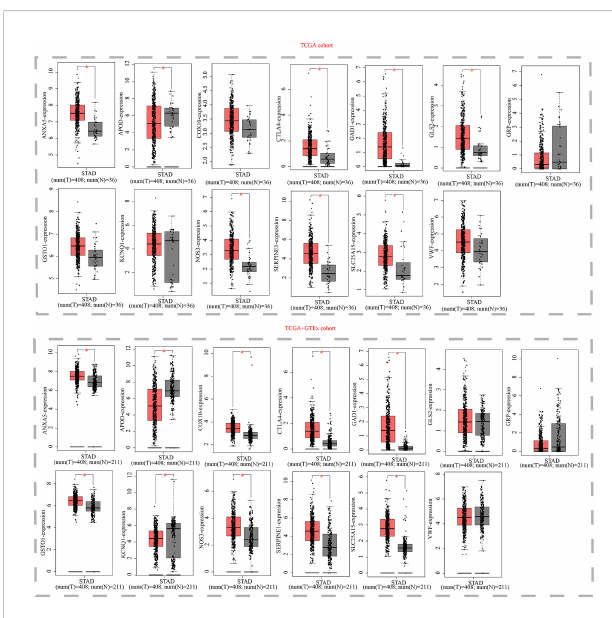
FIGURE 11 Expression validation of thirteen models OMRGs from the GEPIA database. (Box above represents the expression difference between STAD and normal samples derived from TCGA; the box below represents the expression difference between STAD and normal samples derived from TCGA and GTEX). *P < 0.05.